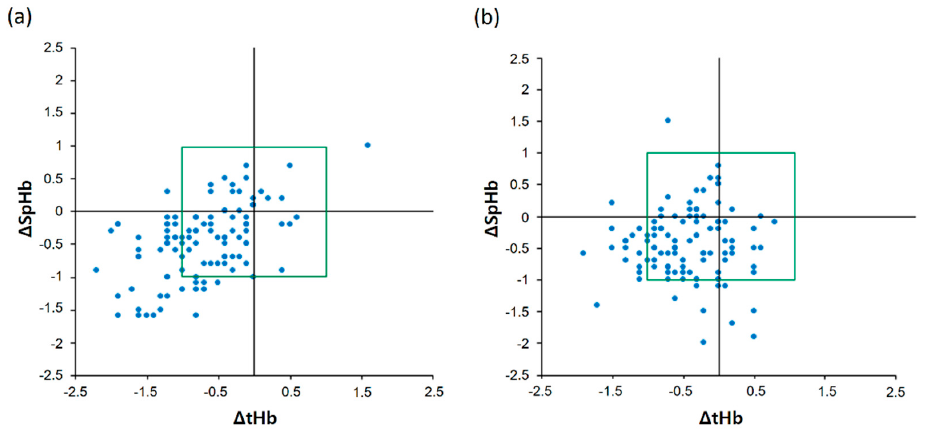
Figure 4. Four-quadrant plot showing changes in real-time continuous hemoglobin values and laboratory hemoglobin values in the low carbon dioxide (CO 2 ) ( a ) and high CO 2 groups ( b ) .